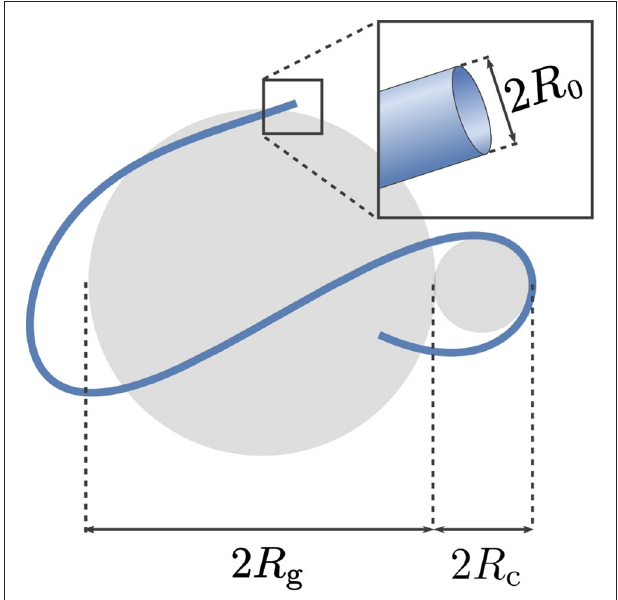
FIGURE 2 | The relevant size parameters of a simplified neural projection (ignoring branchings and other features such as beading patterns [34]) are: its contour length denoted by ℓ , its radius of gyration R g , the characteristic radius of curvature R c , and the radius of the projection’s cross-section R 0